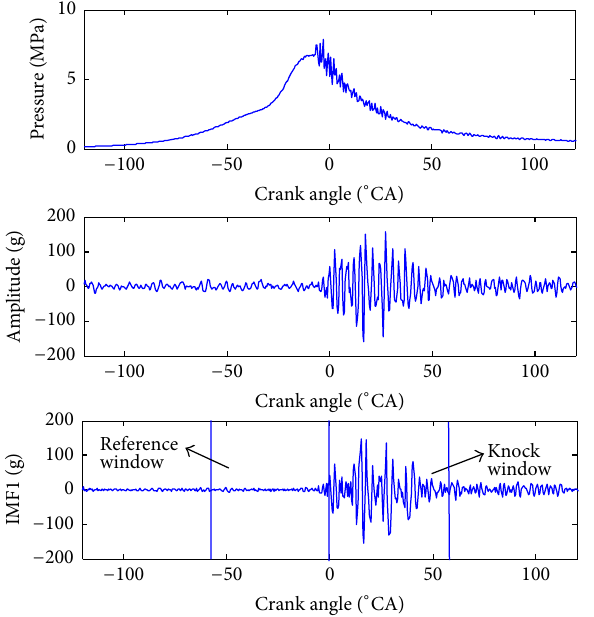
Figure 18: The cylinder pressure signal and the IMF1 of cylinder block vibration signal.